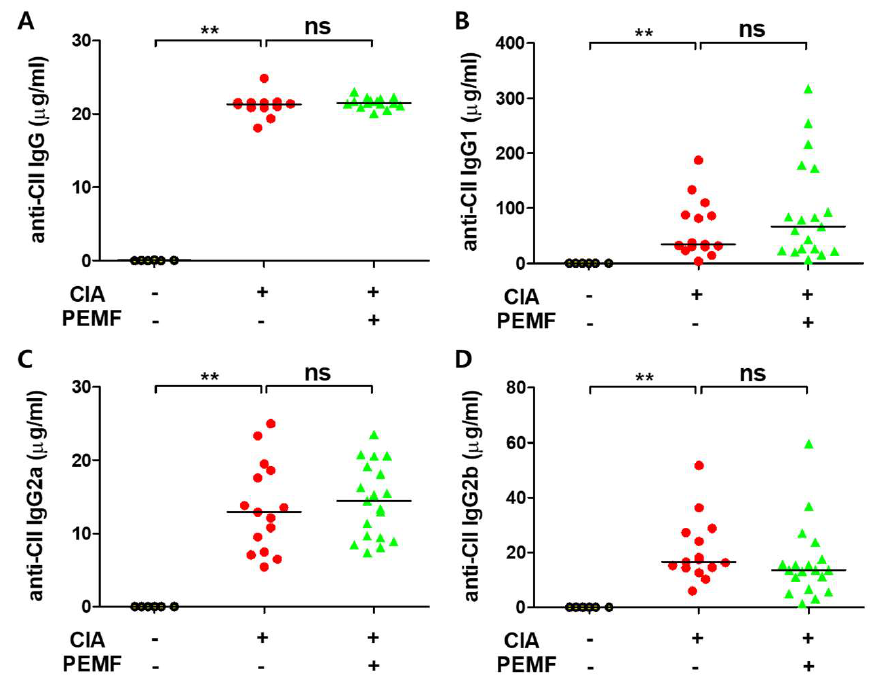
Figure 4. Effects of PEMF (10 Hz) on serum anti-type II collagen autoantibody levels. Levels of ( A ) anti-type II collagen IgG and its subtypes, including ( B ) IgG1, ( C ) IgG2a, and ( D ) IgG2b, were measured by ELISA in serum obtained on day 60 from each mice group. Grouped quantitative data are presented as the median. Significance was measured using a two-tailed Student’s t -test (** p < 0.01 and ns, not significant). Bars indicate the median. Each dot represents one mouse.